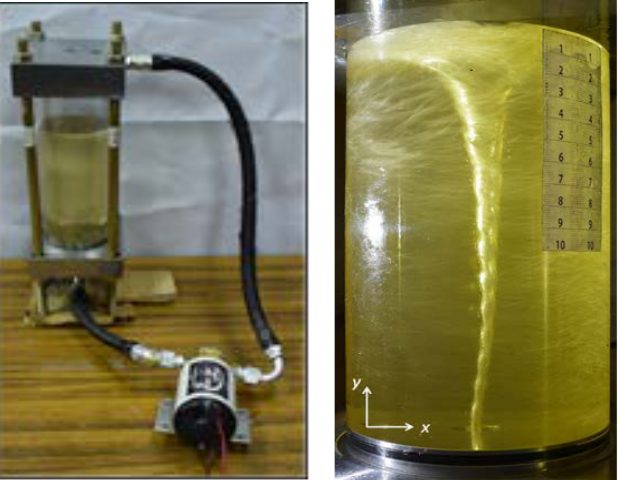
Figure 1. Experimental apparatus and flow of the oil tank.